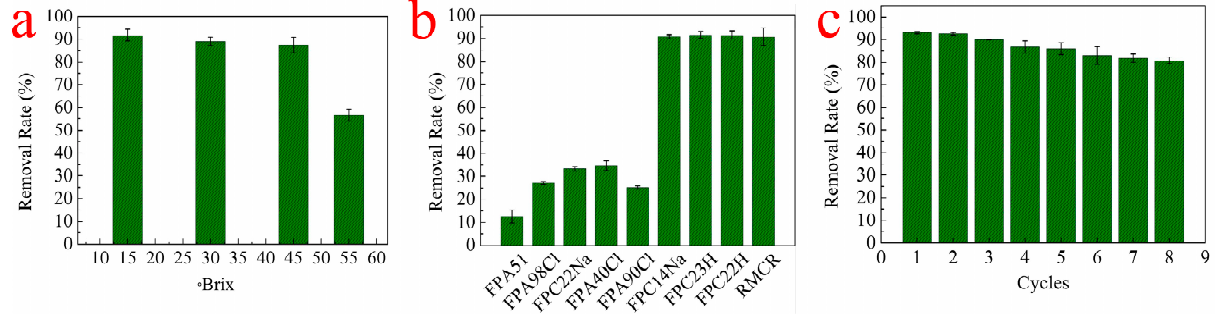
Figure 6. Effect of remelt syrup Brix on calcium ions adsorption onto RMCRs ( a ), comparison with various commercial resins ( b ), and reusability of RMCRs for calcium ions uptake ( c ).